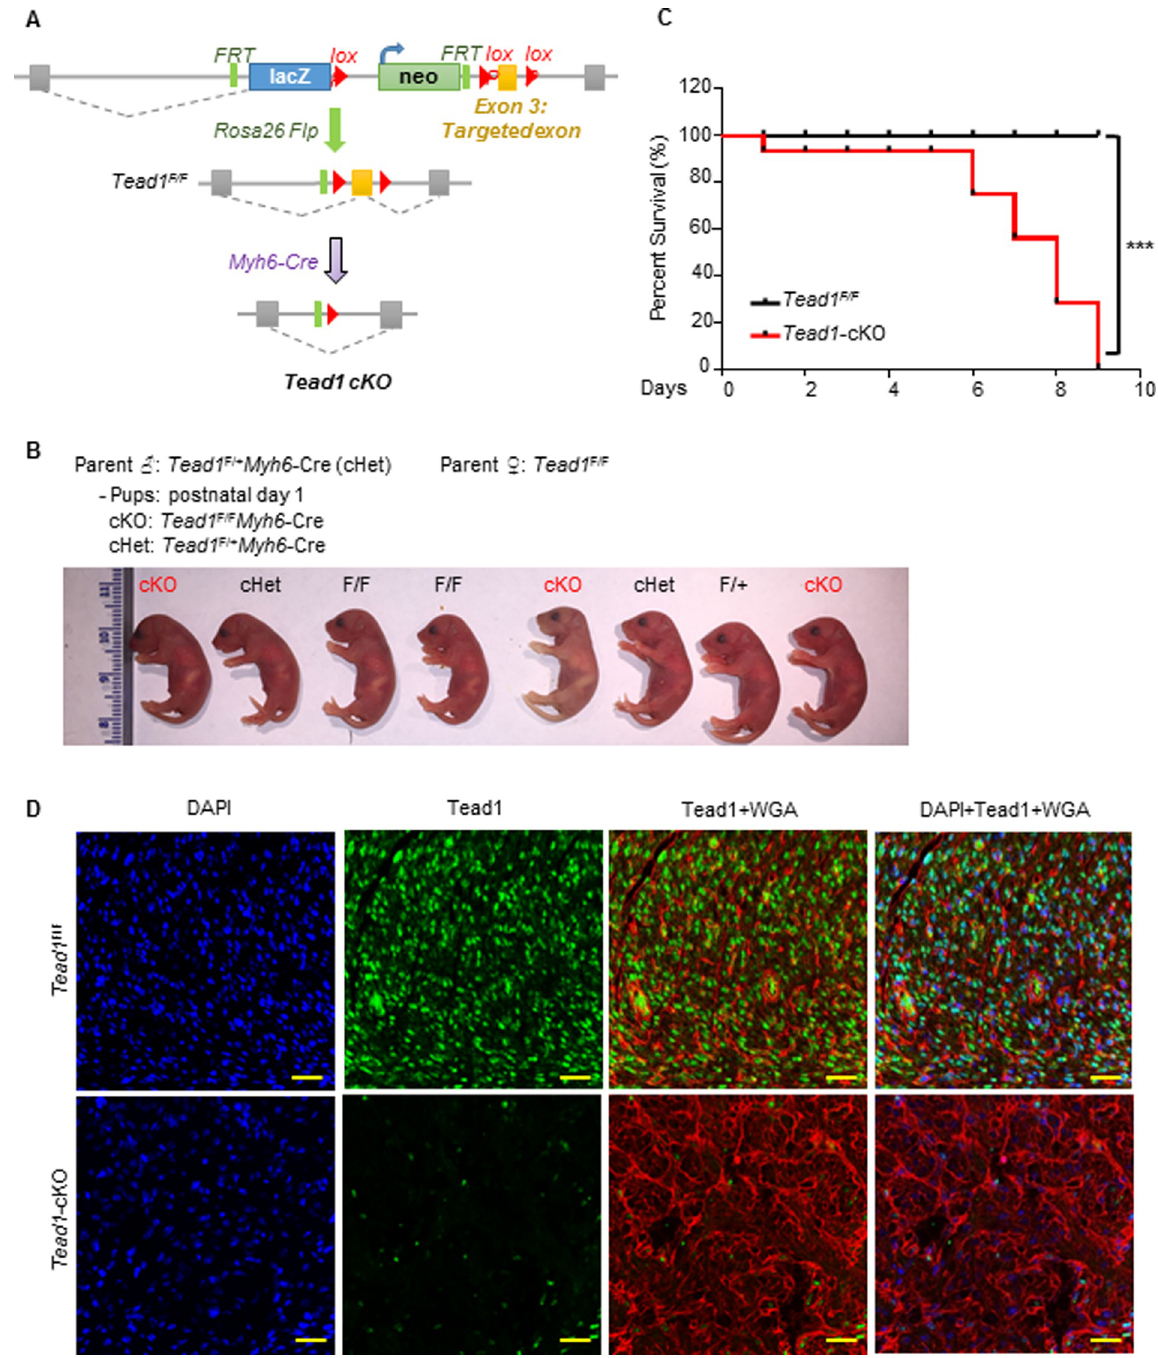
Fig 1. Cardiomyocyte-specific deletion of Tead1 leads to early neonatal death by day 9 after birth. ( A ) Generation of Tead1 cardiomyocyte- specific knockout mice ( Tead1 -cKO) using knockout-first strategy: promoter-driven selection cassette. ( B ) Representative photograph of a Tead1 -cKO breeding litter, demonstrating Tead1 -cKO were born in Mendelian manner and not overtly distinguishable from littermates. ( C ) Kaplan-Meier survival curves of Tead1 F/F littermates and Tead1 -cKO mice. n = 15 mice per group. ��� p < 0.001 by log-rank (Mantel-Cox) test ( D ) Immunostaining in day 1 heart section verifying Tead1 deletion. Scale bar, 50 μ m.